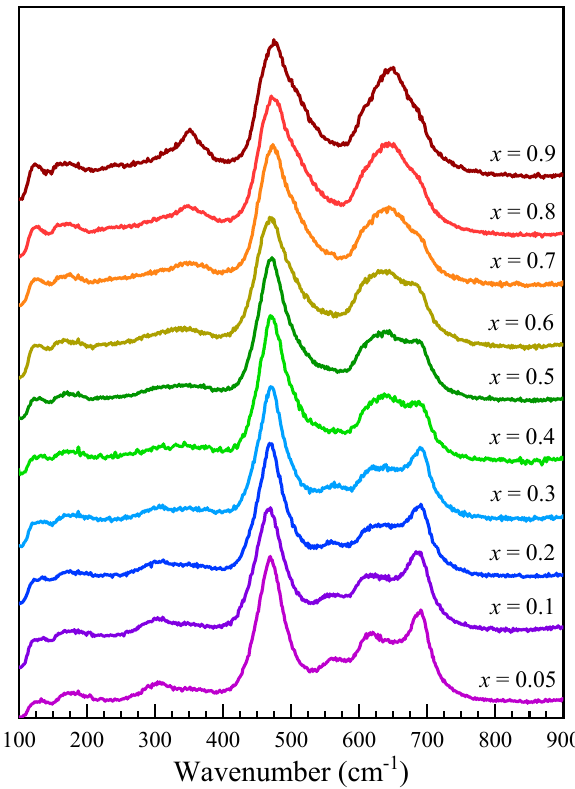
Figure 5. Raman spectra of Co 1-x Zn x Fe 2 O 4 nanoparticles .